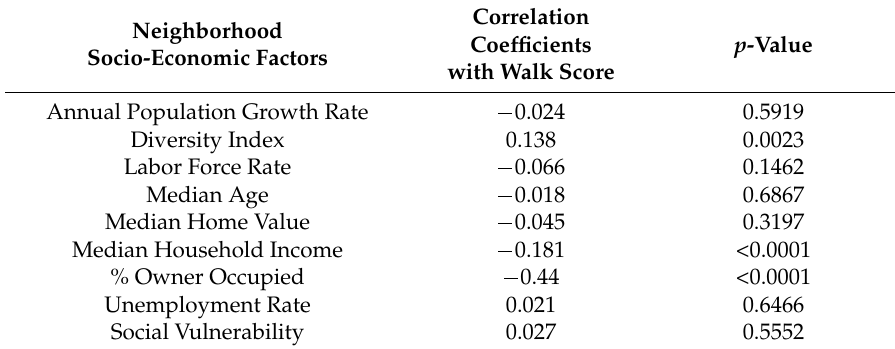
Table 4. Correlation coefficients between walk score and each of neighborhood socio-economic factors.